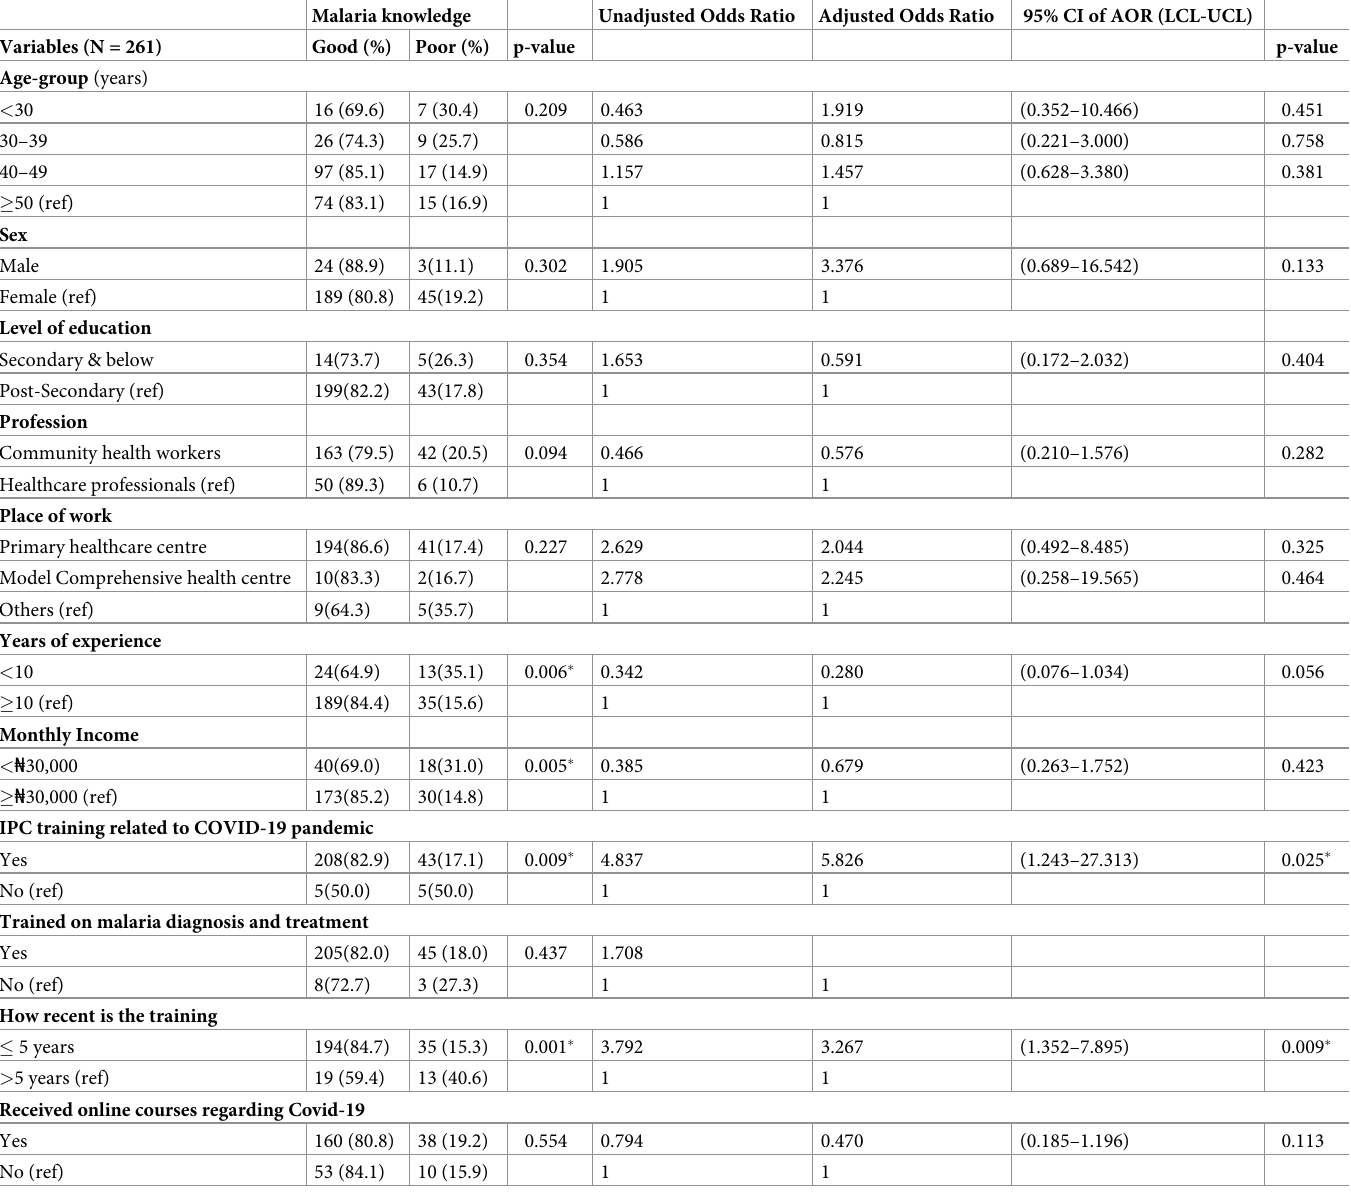
Table 2. Factors influencing malaria knowledge of healthcare